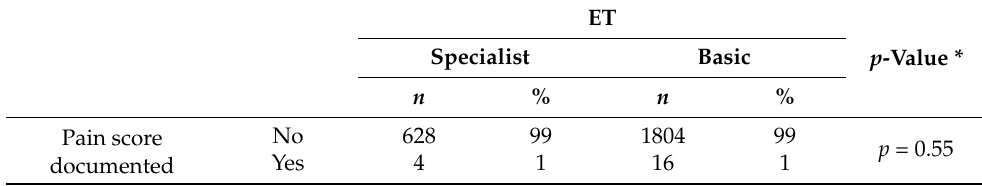
Table 2. The frequency of use of pain score documented by different types of